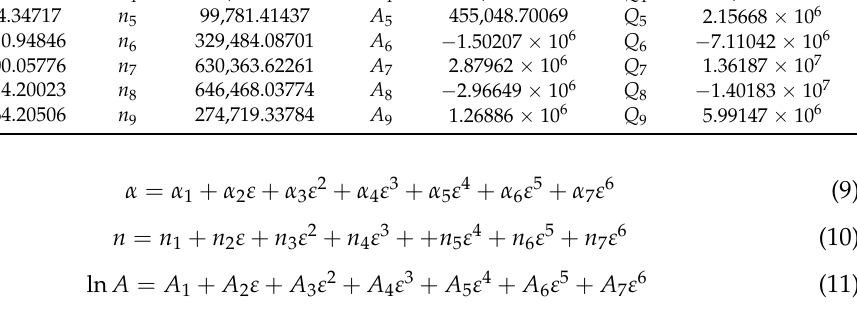
Figure 7. The relationship between the values and true strains. ( a ) α , ( b ) n , ( c ) ln A , ( d ) Q . Table 1. Coefficients of the fitted polynomial functions.